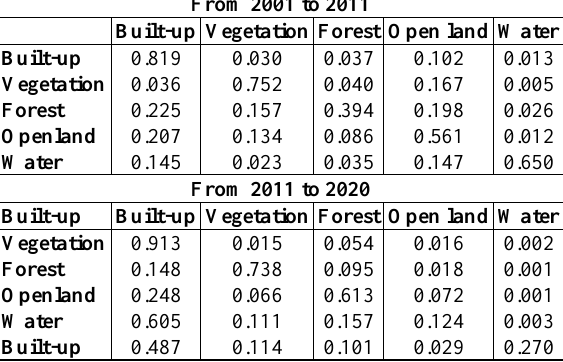
Table 3. Transition matrix of Delhi for the years 2001-2011